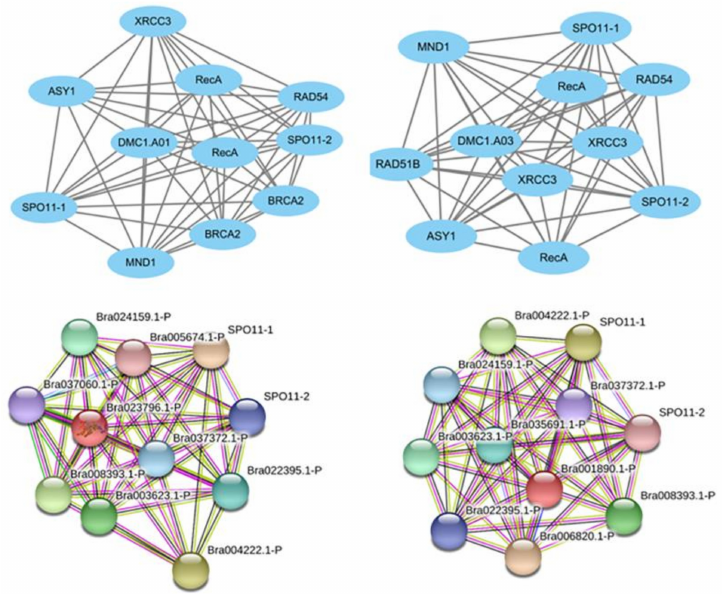
Figure 2. BrDMC1 interaction network analysis was obtained from the STRING database and built using Cytoscape